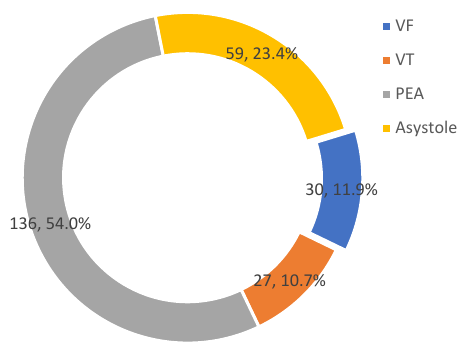
Figure 1. Initial documented rhythm of the participants